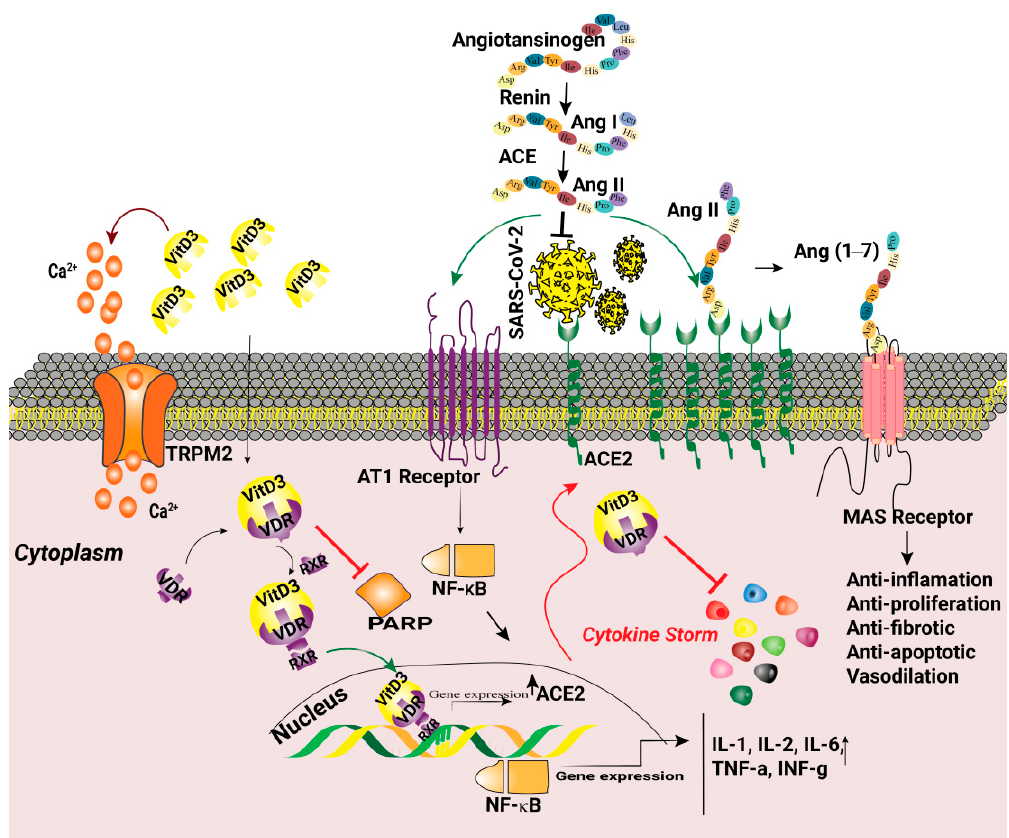
Figure 2. Overactivation of the renin-angiotensin system (RAAS) is a consequence of SARS-CoV-2 infection. Binding S protein to the angiotensin-converting enzyme 2 (ACE2) leads to receptor inter- nalization and downregulation and causes upregulation of AngII. AngII binds to AT1R and acti- vates the NF ĸ B pathway, causing the release of pro-inflammatory cytokines and inducing oxida- tive stress. Vitamin D3-VDR-RXR complex increases ACE2 and ACE2 augments the generation of angiotensin 1–7 (Ang (1–7)) by metabolizing Ang II. The Mas receptor (MasR) activated by Ang (1–7) induces beneficial actions such as anti-inflammation, anti-proliferation, anti-fibrotic, anti- apoptotic, and vasodilation. Vitamin D3 (VitD3) is also a poly(ADP-ribose) polymerase (PARP) inhibitor. VitD3 increases extracellular Ca 2+ and results in the activation of transient receptor po- tential channels, melastatin 2 (TRPM2), and parthanatos.